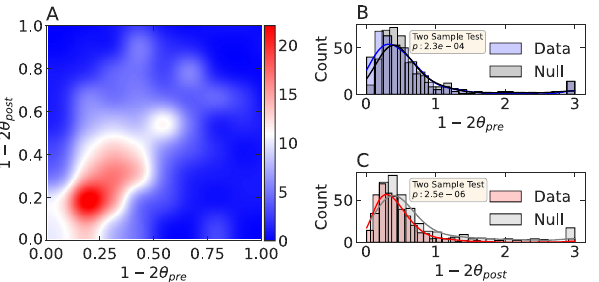
Figure 4. Joint and marginal distribution of pre-peak and post-peak relaxation exponents in YouTube success: we calibrate the individual daily channel view time series to find the dependence of pre- and post-peak exponents. ( A ) Joint distribution of pre-peak and post-peak exponents. The highest density of points cluster near 0.5. The fuzzy C-mean clustering gives the centroid of the distribution to be ∼ ( 0.5, 0.5 ) . ( B ) Marginal distribution of pre-peak exponents obtained from the data and the pre-peak exponents obtained from randomly shuffled null data. The two-sample Kolmogorov–Smirnov test suggests that the distribution of the exponents obtained from data is significantly different than that of the exponents in null. ( C ) same as ( B ), except the exponent values represent the post-peak